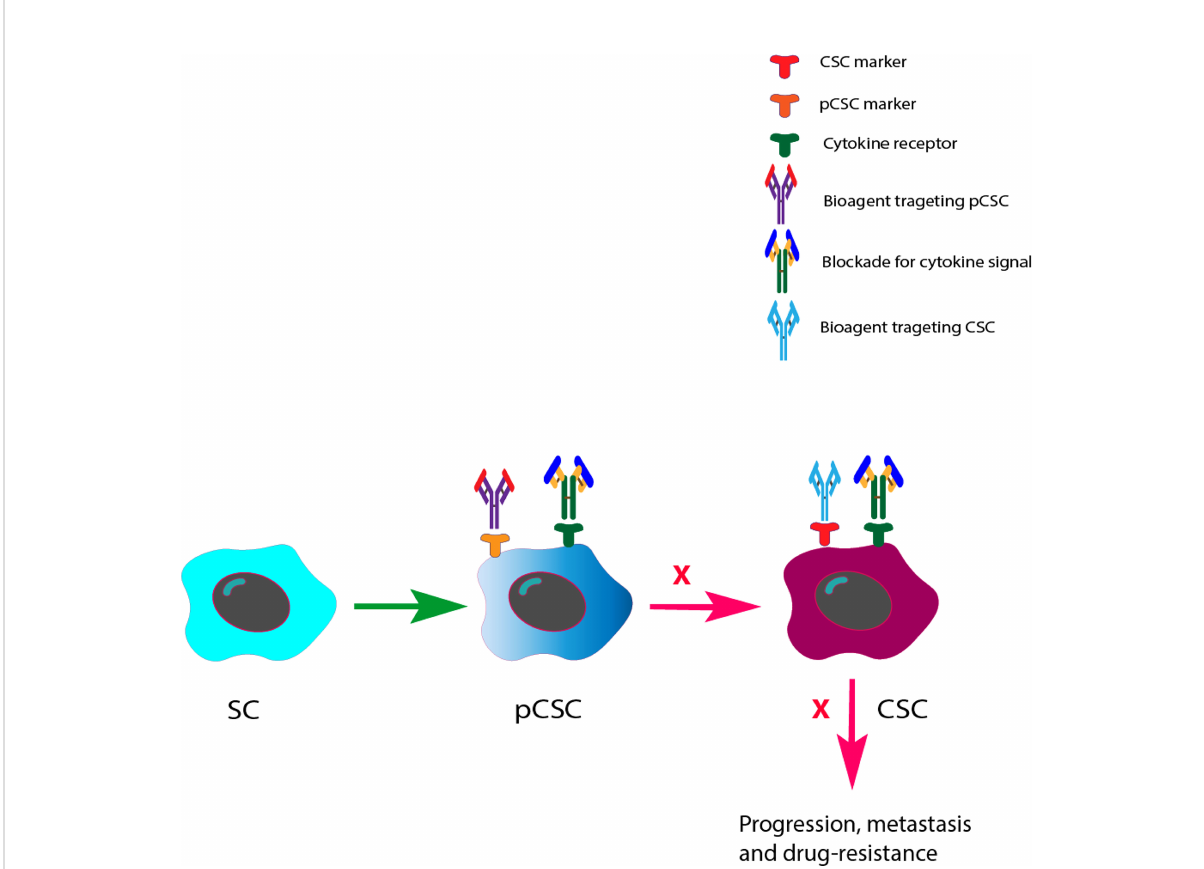
FIGURE 2 Future perspectives of cytokine signal blockades with pCSC/CSC target therapies in the prevention and inhibition of CRC development and progression. Based on the previous fi nding that pCSCs have an potential for bidirectional differentiation to both benign and malignant lesions, we therefore prospected that bioagents that can precisely target pCSCs/CSCs with cytokine signals may change both the differentiation direction of pCSCs at the precancerous stage and the effect of CSCs at the CRC